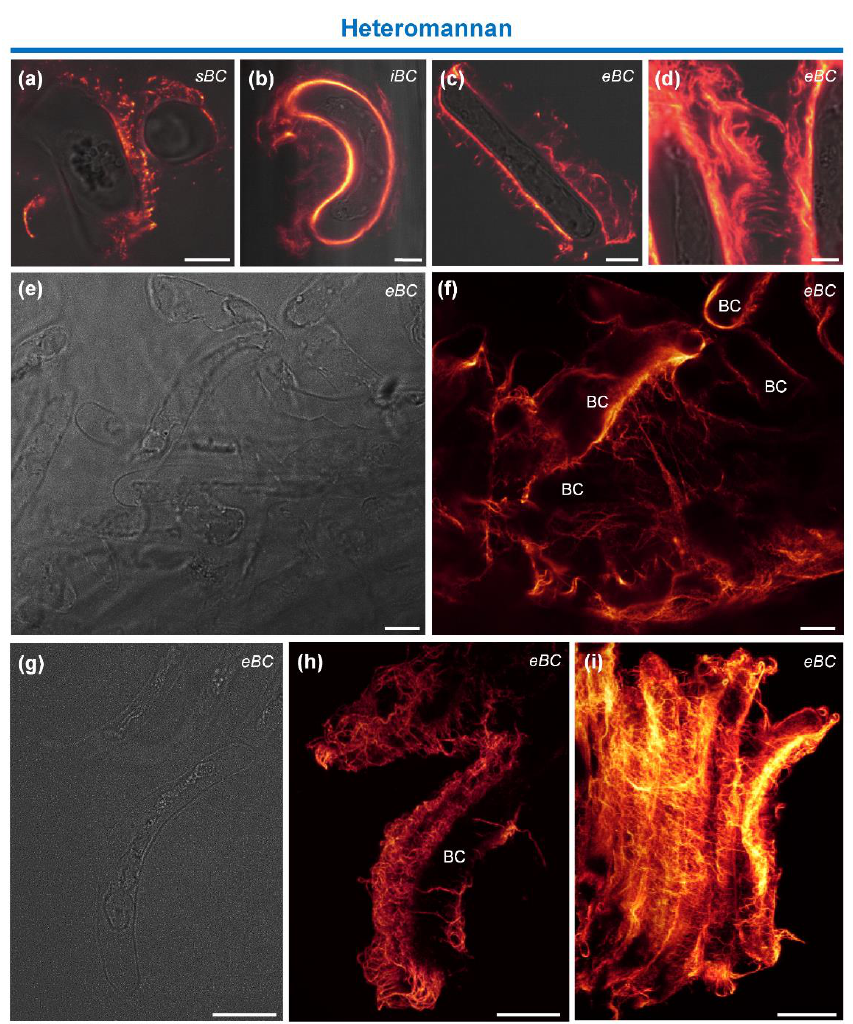
Figure 6. Immunolocalization of heteromannan epitopes. ( a – d , f , h , i ) Immunofluorescence images showing labeling of the cell wall and extracellular material in all BC morphotypes with the mAbs LM21. Stained fibrillary material is observed around the cells and between them. ( h , i ) Stack images reconstitution reveals a very dense hairy network covering the cells and holding several of them together. ( e , g ) Bright field images corresponding to fluorescence images in ( f , h ). sBC, spherical border cells; iBC, intermediate border cells; eBC, elongated border cells. Scale bars: ( a – c ) 10 µm; ( d ) 5 µm; and ( e – i ) 25 µm.